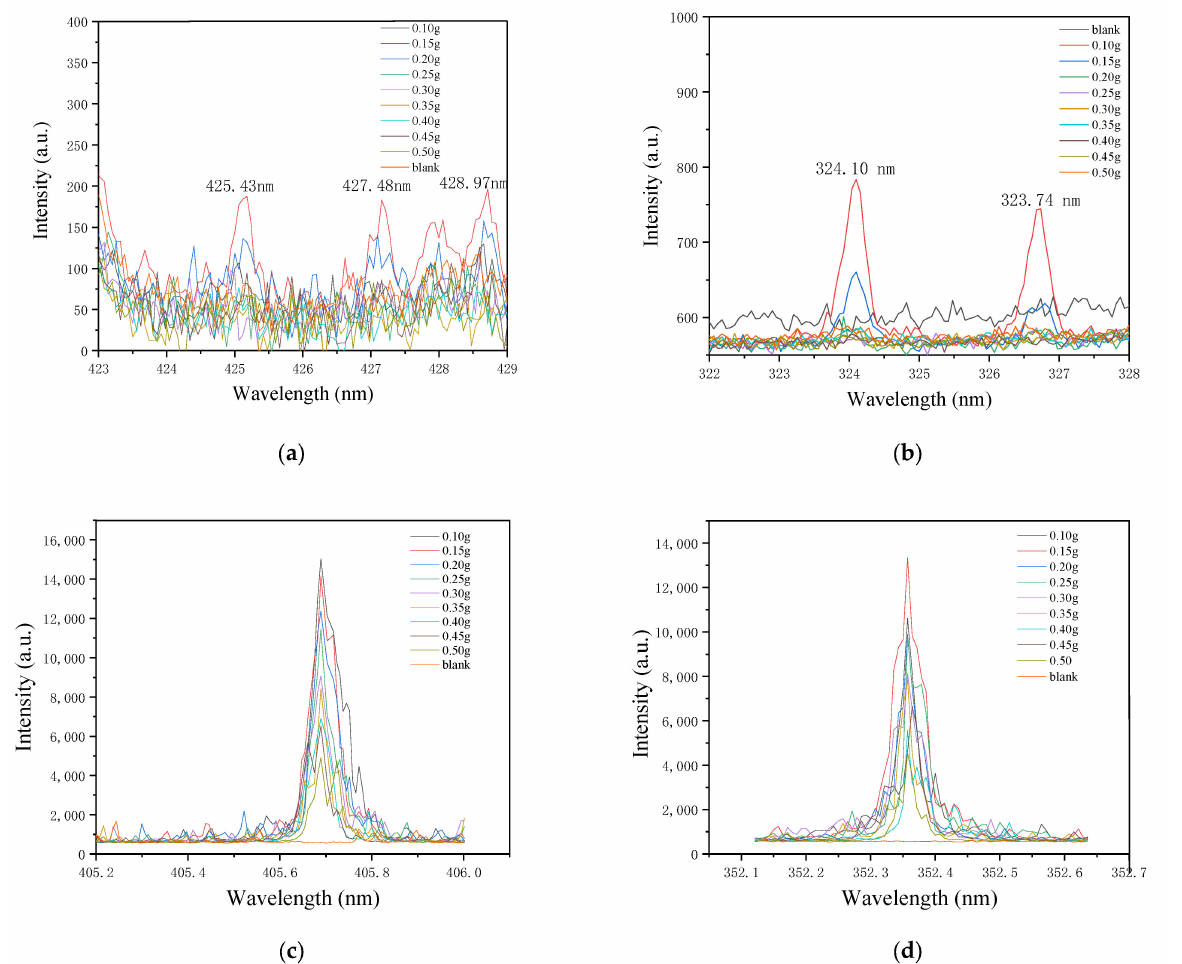
Figure 6. Optimization of resin content on the emission of ( a ) Cr; ( b ) Cu; ( c ) Pb; ( d )